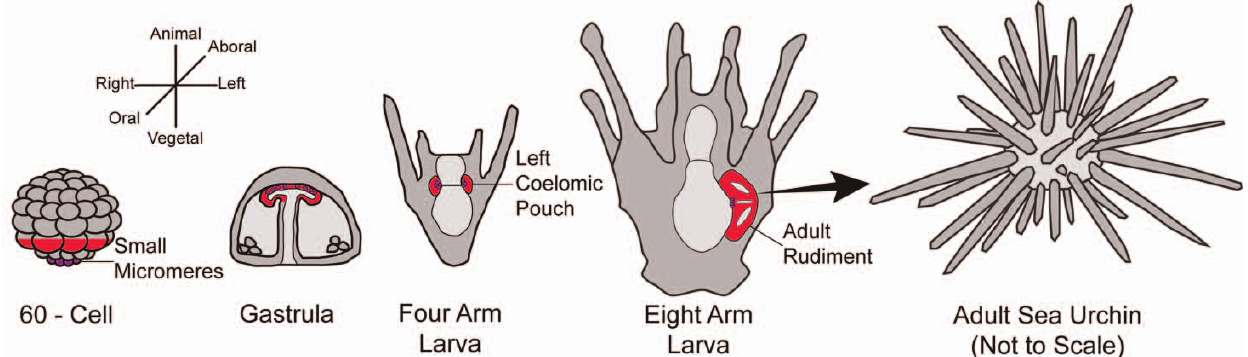
Figure 1. Left-right asymmetry in the sea urchin. During cleavage, mesoderm (red cells at 60-cell stage) and small micromeres (purple cells at vegetal pole) become specified. At the end of gastrulation, progeny of these two cell types contribute to the coelomic pouches (red and purple outpockets seen at the tip of the archenteron). During larval stages, the adult rudiment grows from the left coelomic pouch. After metamorphosis, that rudiment grows to become the adult. Embryonic axes are shown relative to the 60-cell cleavage and gastrula stages. The aboral-oral axis is also known as the dorsal-ventral axis. The animal-vegetal axis is the only axis established prior to fertilization. Oral-aboral axis specification occurs early in cleavage, and left-right axis determination occurs at the late gastrula